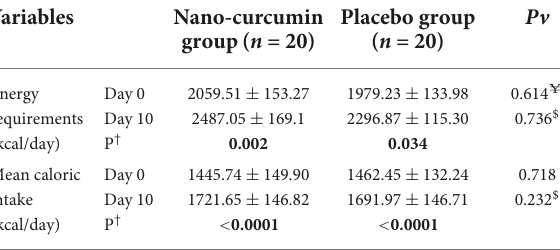
TABLE 3 Summary of baseline characteristics of the patients. TABLE 4 Changes nutritional status during the